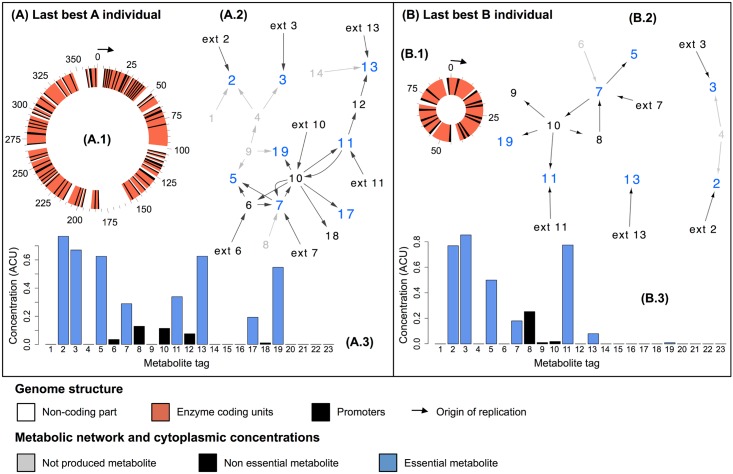
Final best individuals of groups A and B, from repetition 10 of the periodic environment.(A) Final best organism A. (B) Final best organism B. (A.1, B.1) The circular single-stranded genome. Non-functional regions are white, promoters black, E red, revealing numerous operons all along the genomes. (A.2, B.2) The metabolic network. Non essential and essential metabolites are colored in black and blue, respectively. Non-functional parts of the metabolic network (where fluxes are null) are shown in grey. (A.3, B.3) The internal metabolic concentrations (non essential metabolite concentrations: black. Essential metabolite concentrations: blue).